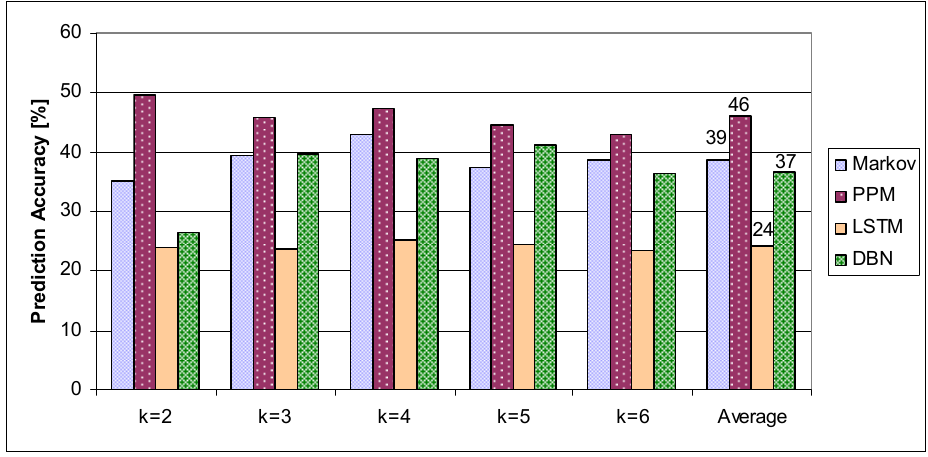
Figure 11. Prediction accuracy with the mood variable through k ‐ fold cross ‐ validation.